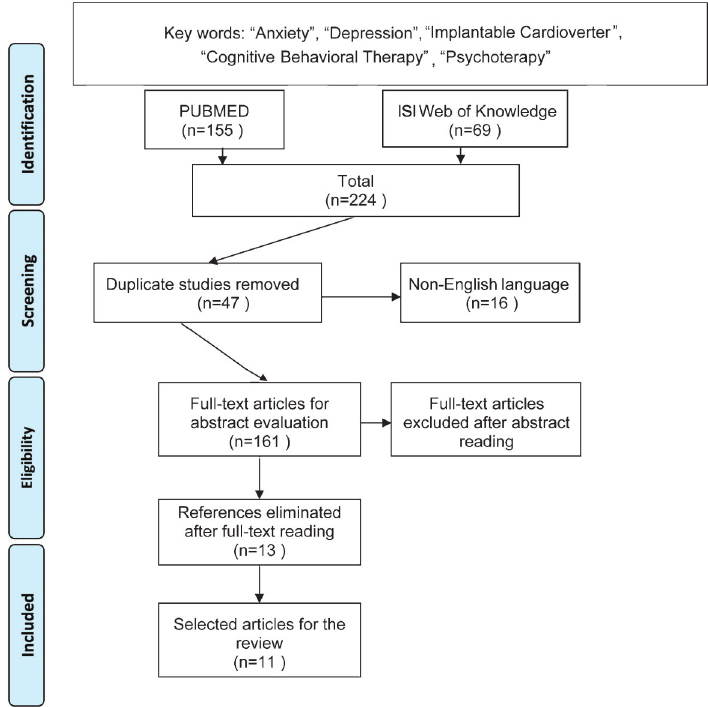
Figure 1. Results of the integrative